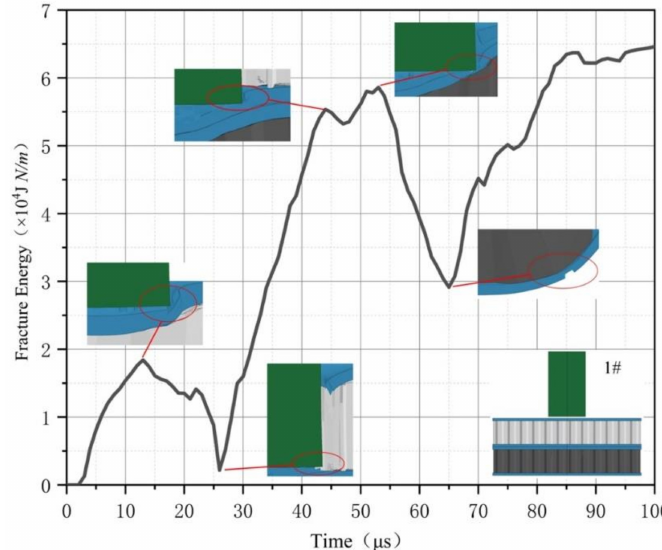
Figure 8. Curve of 1# fracture energy.